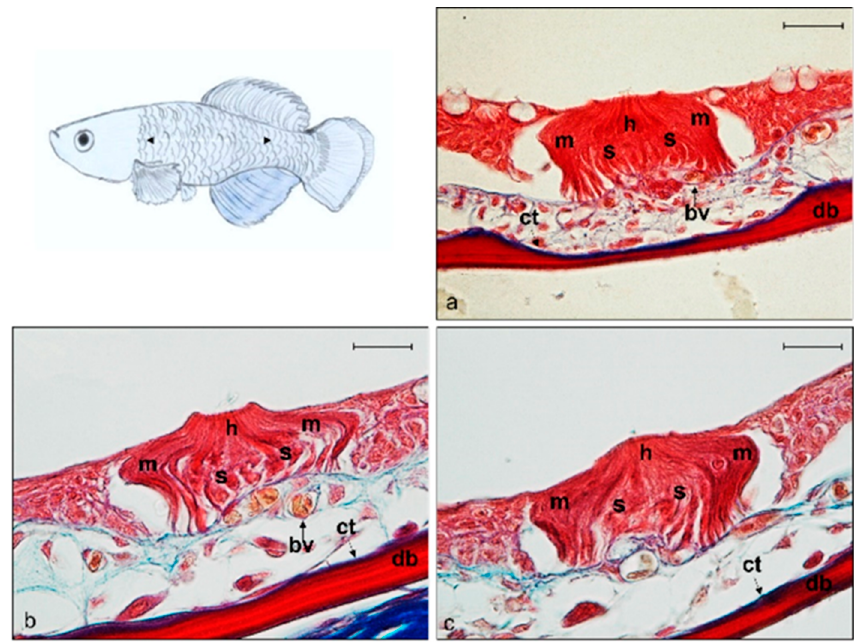
Figure 4. Light micrographs (Masson Trichrome with blue staining) ( a,b,c ) of lateral line system of N. guentheri trunk; transversal view. Superficial free neuromast in N. guentheri trunk shows a group of hair sensory cells (h) supported by supporting cells (s) and surrounded laterally by long mantle cells (m). bv (arrow) blood vessels, bm basal membrane, ct (arrow) connective tissue, db dermal bone. Magnification 40X, scale bar 50 µm.